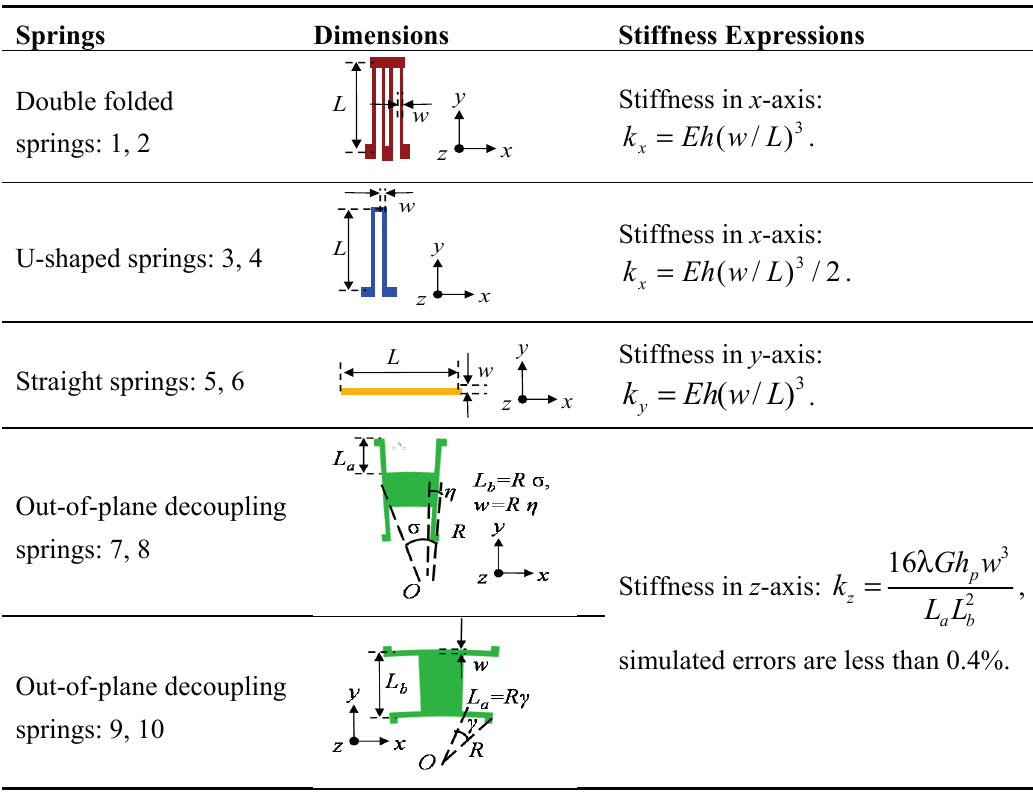
Table 3. The stiffness expressions of different